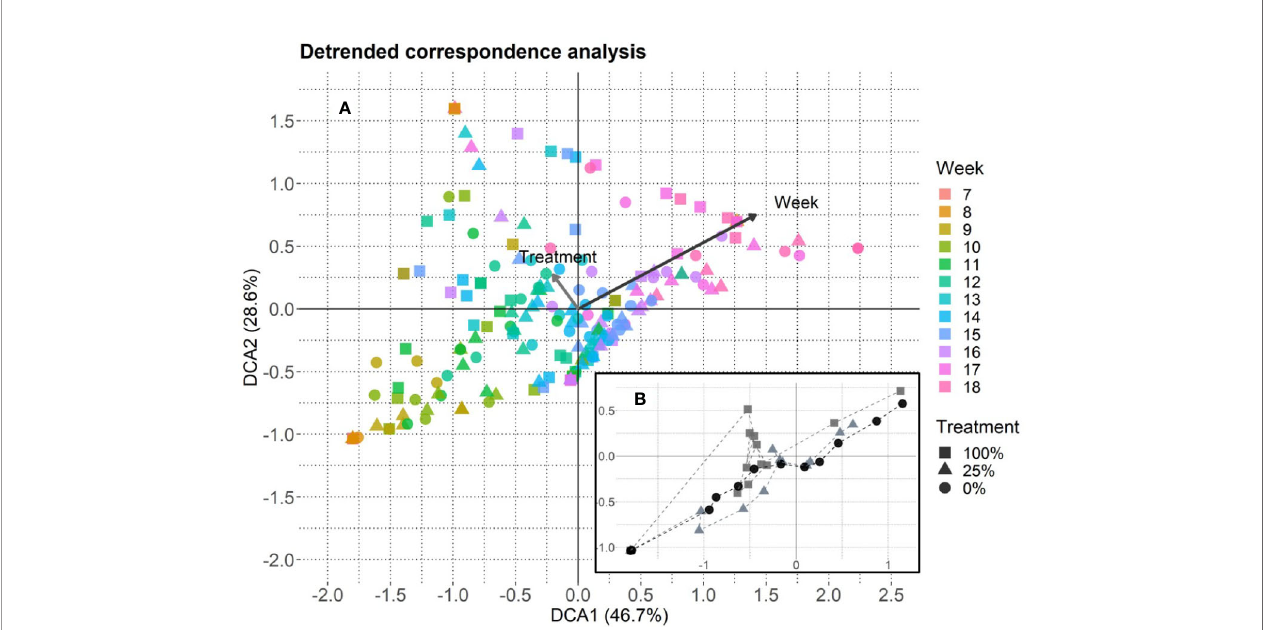
FIGURE 4 | Detrended correspondence analysis based on species-speci fi c fl owering data, axis lengths: DCA1 = 4.03 and DCA2 = 2.63. (A) One data point represents one EcoUnit observed in 1 week (n = 228). The community development over time (18 weeks, starting from week 7 when plant species started to fl ower) is given with a color gradient for week. Eigenvalues are given in percent and represent the explained variance according to the axes. The treatments are represented by fi lled symbols (square = 100%, triangle = 25%, circle = 0%). Variables week and treatment are post-hoc correlated (p < 0.001). Arrows are enlarged in scale by the factor two to fi t the scale of the plot. Their lengths show differences in explained variance relative to each other. (B) DCA-centroids per week and treatment. The dashed lines connect the symbols that represent the plant community fl owering development over